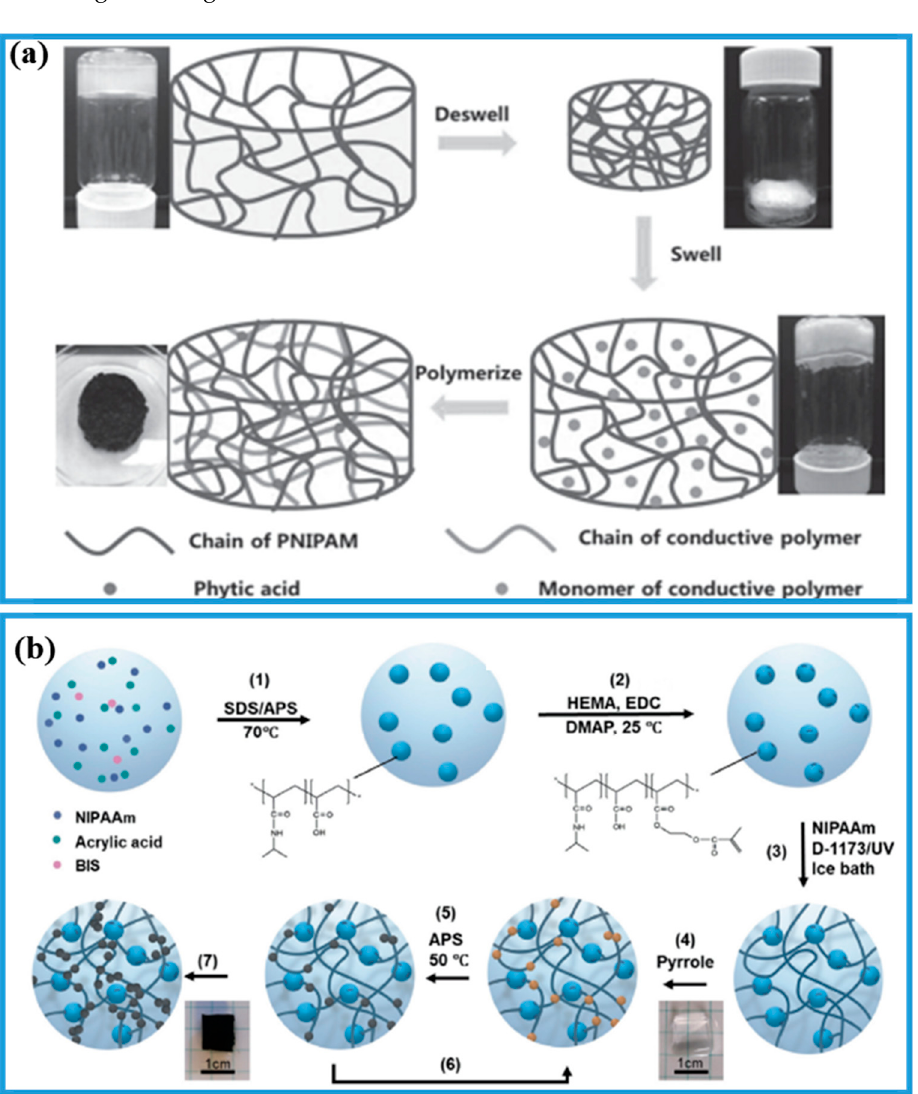
Figure 4. ( a ) Illustration of preparation of PNIPAM-PANI and PNIPAM-PPY double network PNIPAM-ECHs. Copyright from Ref. [65] John Wiley and Sons. ( b ) Illustration of preparation of well-distributed PPY PNIPAM-ECHs. Copyright from Ref. [100]